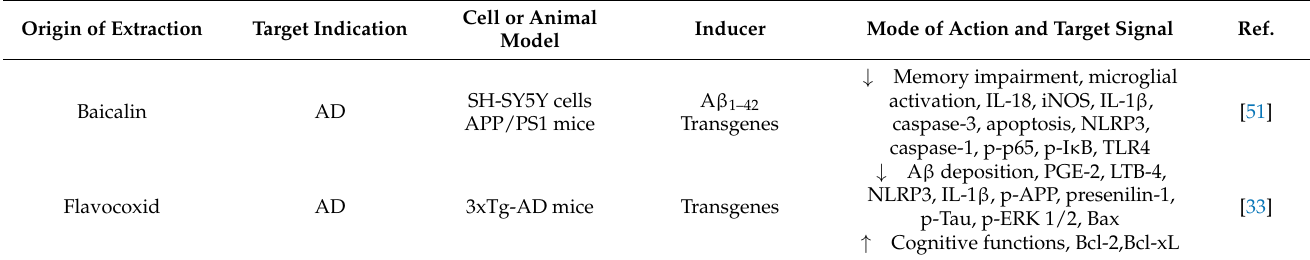
Table 2. NLRP3 inflammasome targeting study of single compound in AD and